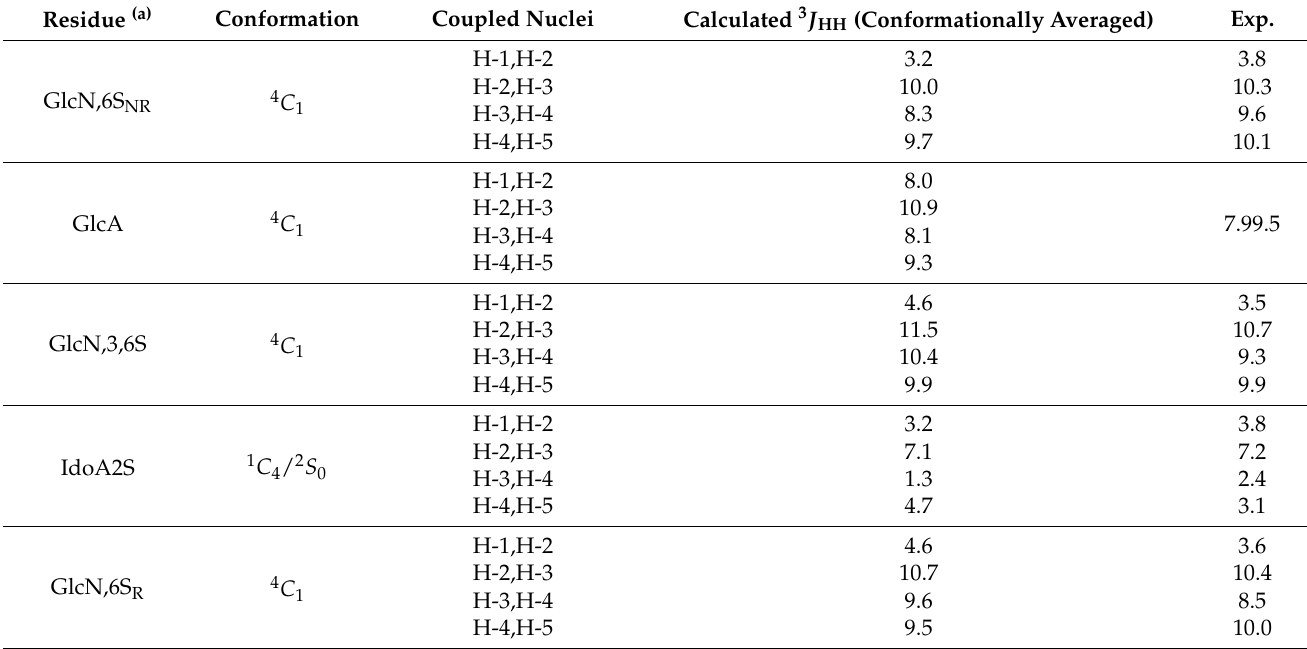
Table 5. Computed averaged vicinal proton-proton coupling constants (Hz) of heparin pentasaccharide as compared to experiment. Compiled from Hricovini